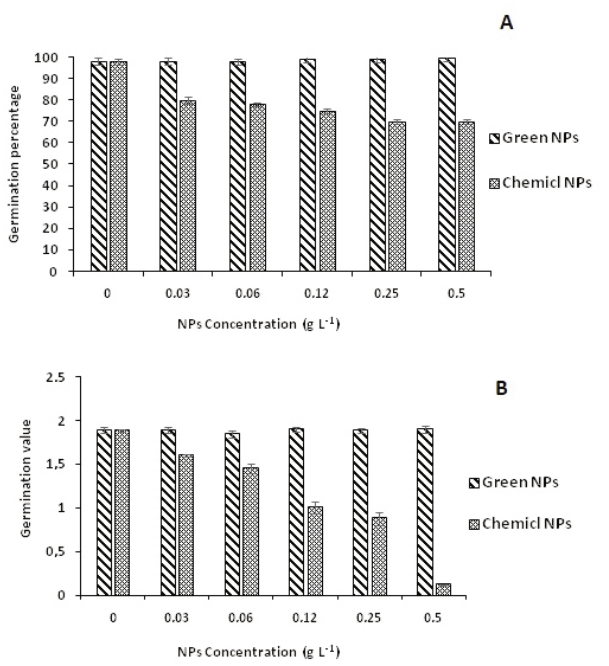
Fig. 4 ­ The influence of AgNPs type and concentration on germi­ nation percentage (A) and germination value (B) in Allium cepa . Means ± SD of six replicates. The same letter denotes lack of a statistically significant difference (Tukey, p<0.01).